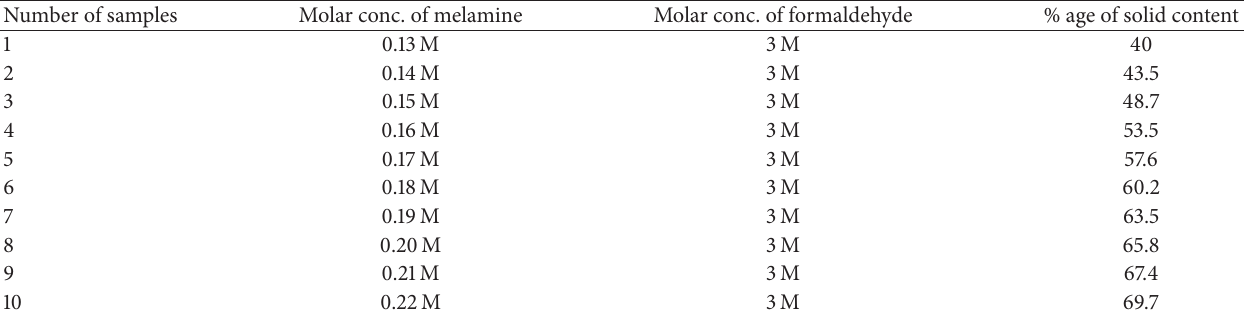
Table 1: Different molar concentration of melamine and formaldehyde resin at temperature 75 ∘ C and pH 8.5.